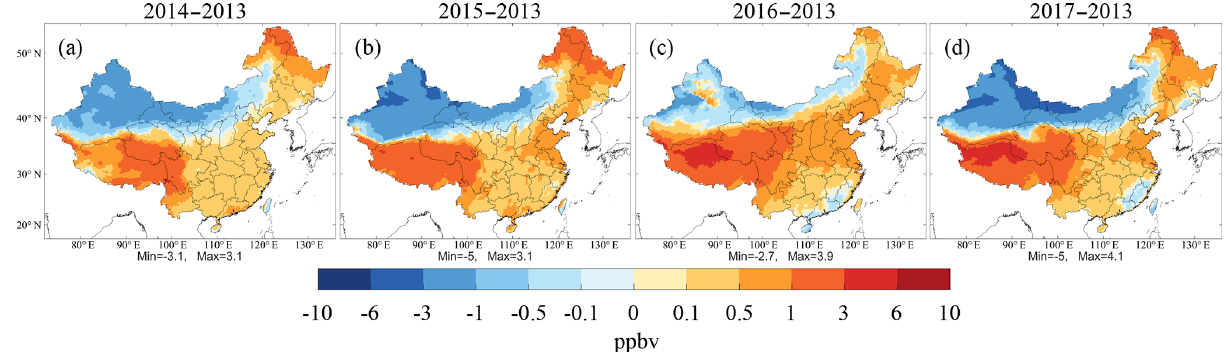
Figure 7. Changes in the simulated summer surface MDA8 O 3 mixing ratios due to variations in long-range transport in 2014, 2015, 2016, and 2017 relative to